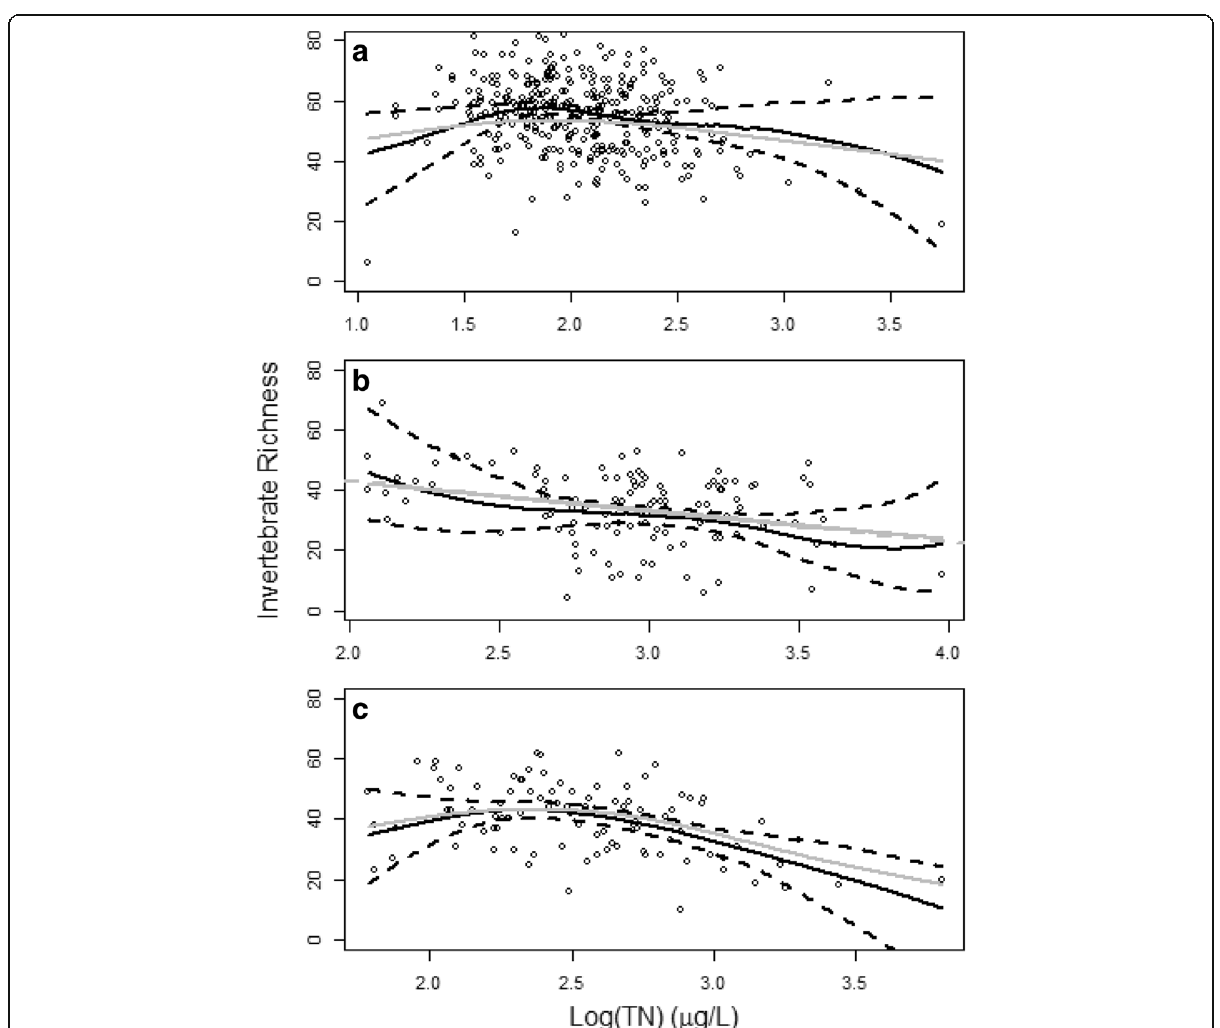
Fig. 5 The causal effects of total nitrogen on invertebrates in different ecoregions of the Western United States. a Forested Mountains. b Great Plains. c North American Deserts. The black solid lines and black dashed lines are the mean estimations by generalized propensity score of the TN-IR dose-response function and the corresponding 95% confidence boundaries, respectively. The gray solid lines are the estimations by the general additive model in a and c and the estimations by simple linear regression in b . The gray dashed line in b is the estimation by multiple linear regressions and nearly overlaps the simple linear regression